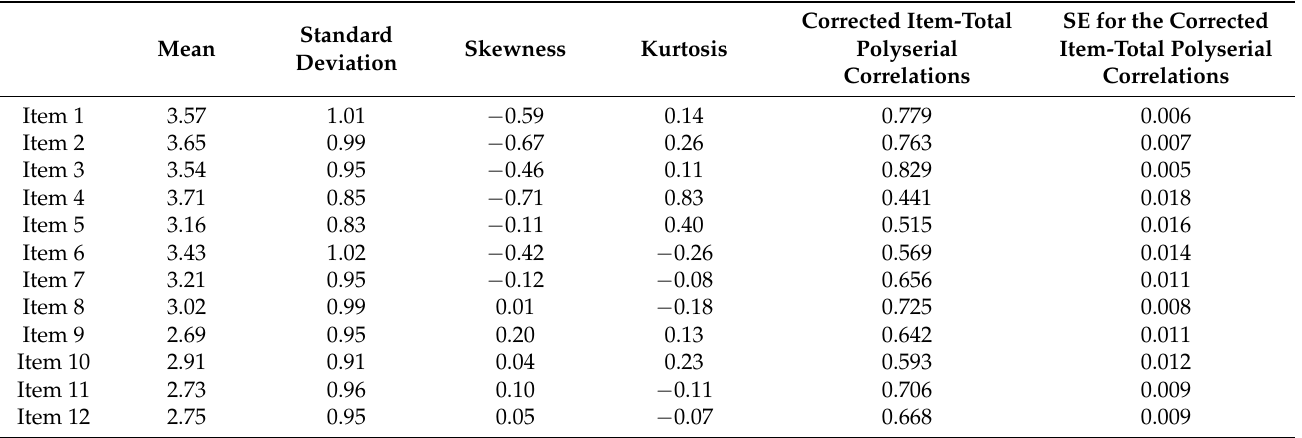
Table 2. Descriptive statistics and corrected item-total polyserial correlations for the items of the Vaccination Attitudes Examination Scale.